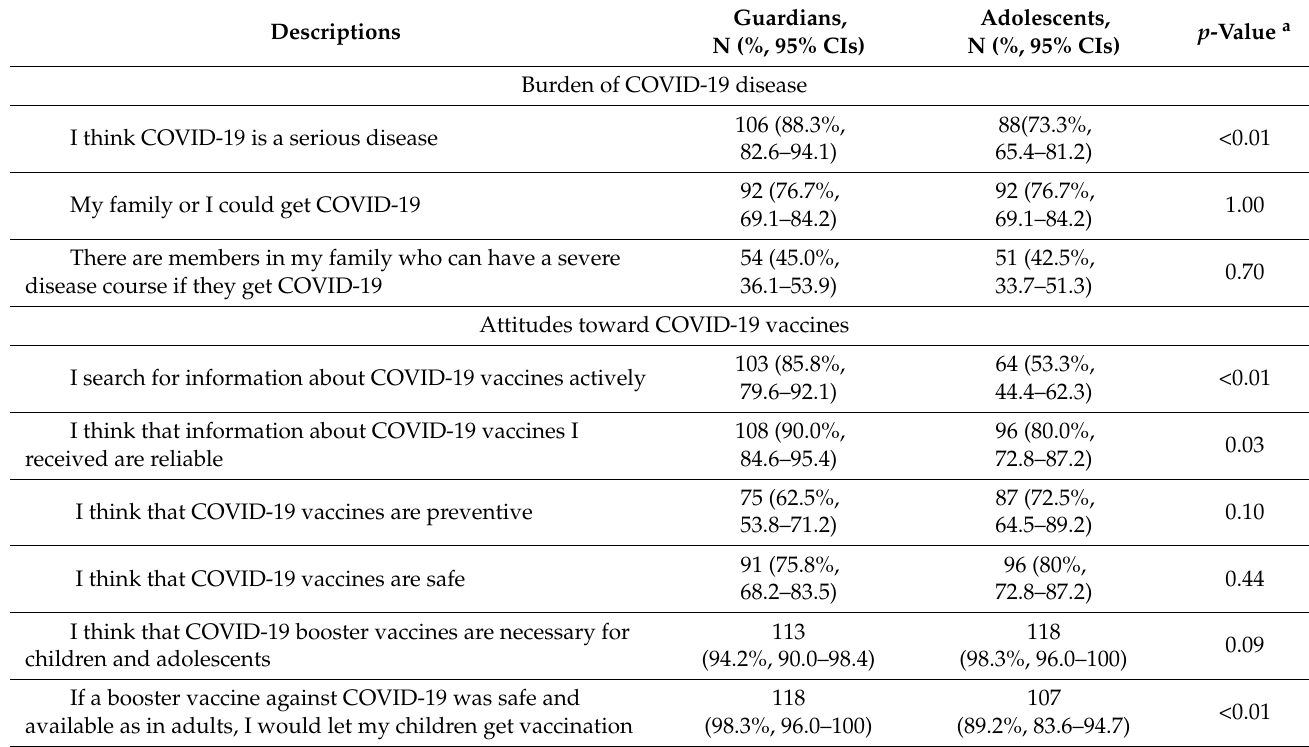
Table 3. Guardians’ and adolescents’ attitudes toward COVID-19 disease and COVID-19